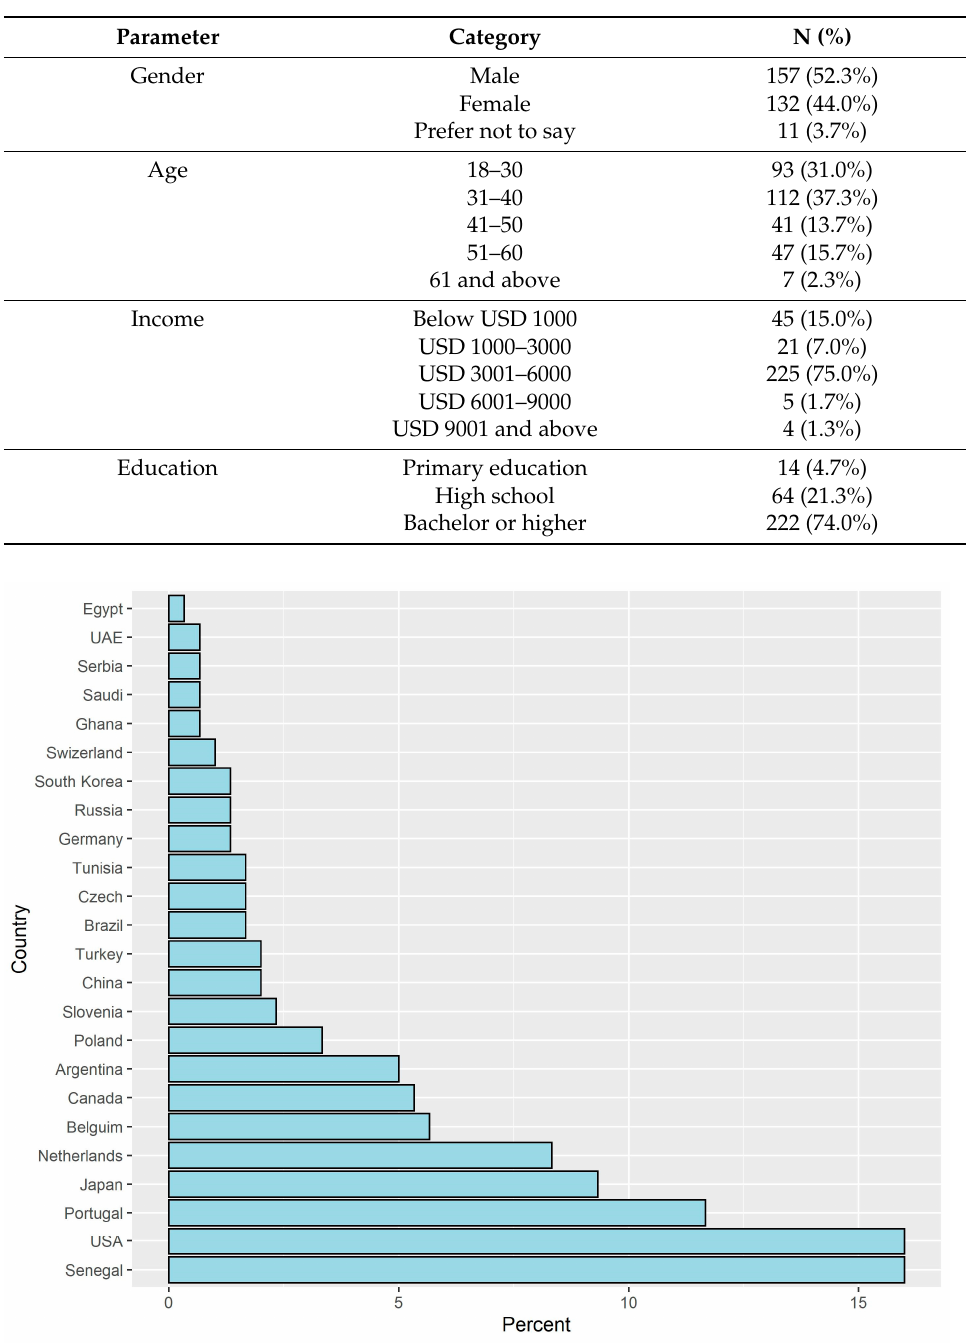
Table 1. Demographic characteristics of world cup fans.